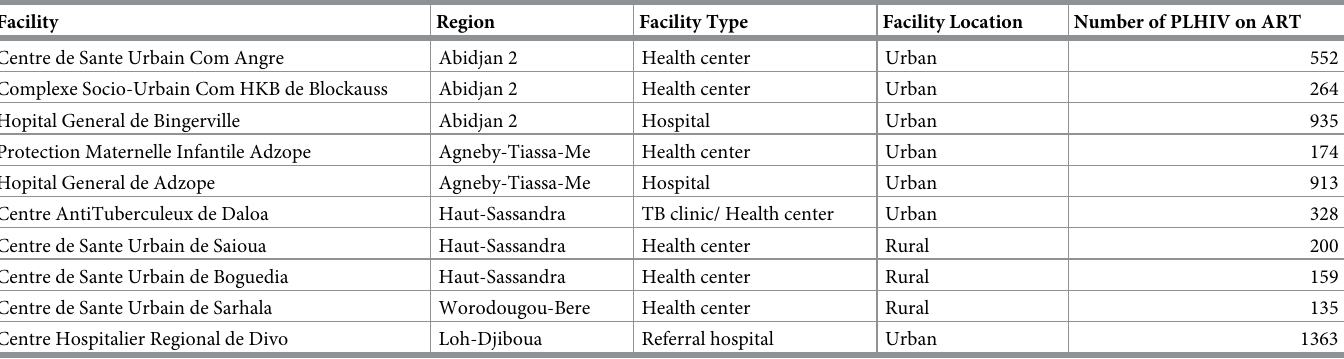
Table 1. List of included